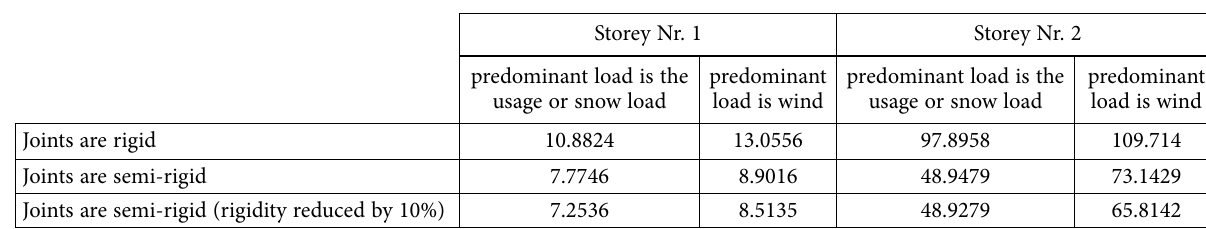
Table 1. Values of α cr Storey Nr. 1 Storey Nr.